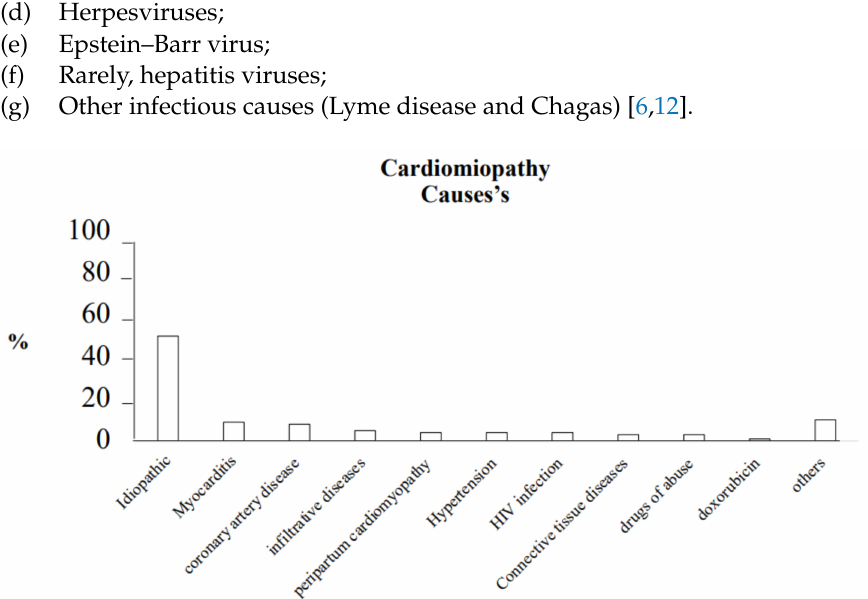
Figure 1. In this figure, we report the most important causes of dilated cardiomyopathy